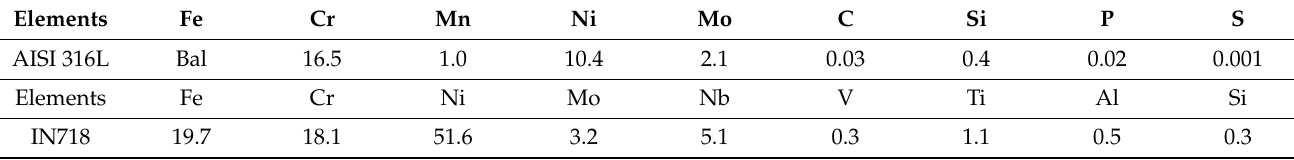
Table 1. Composition of base metals (wt